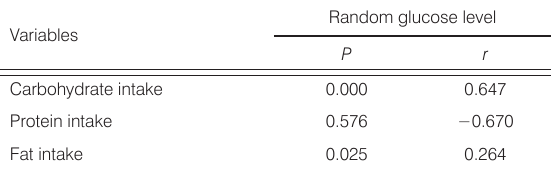
Table 2. Bivariate correlation analysis between the intake of carbohydrates, proteins, and fats and random blood sugar levels.